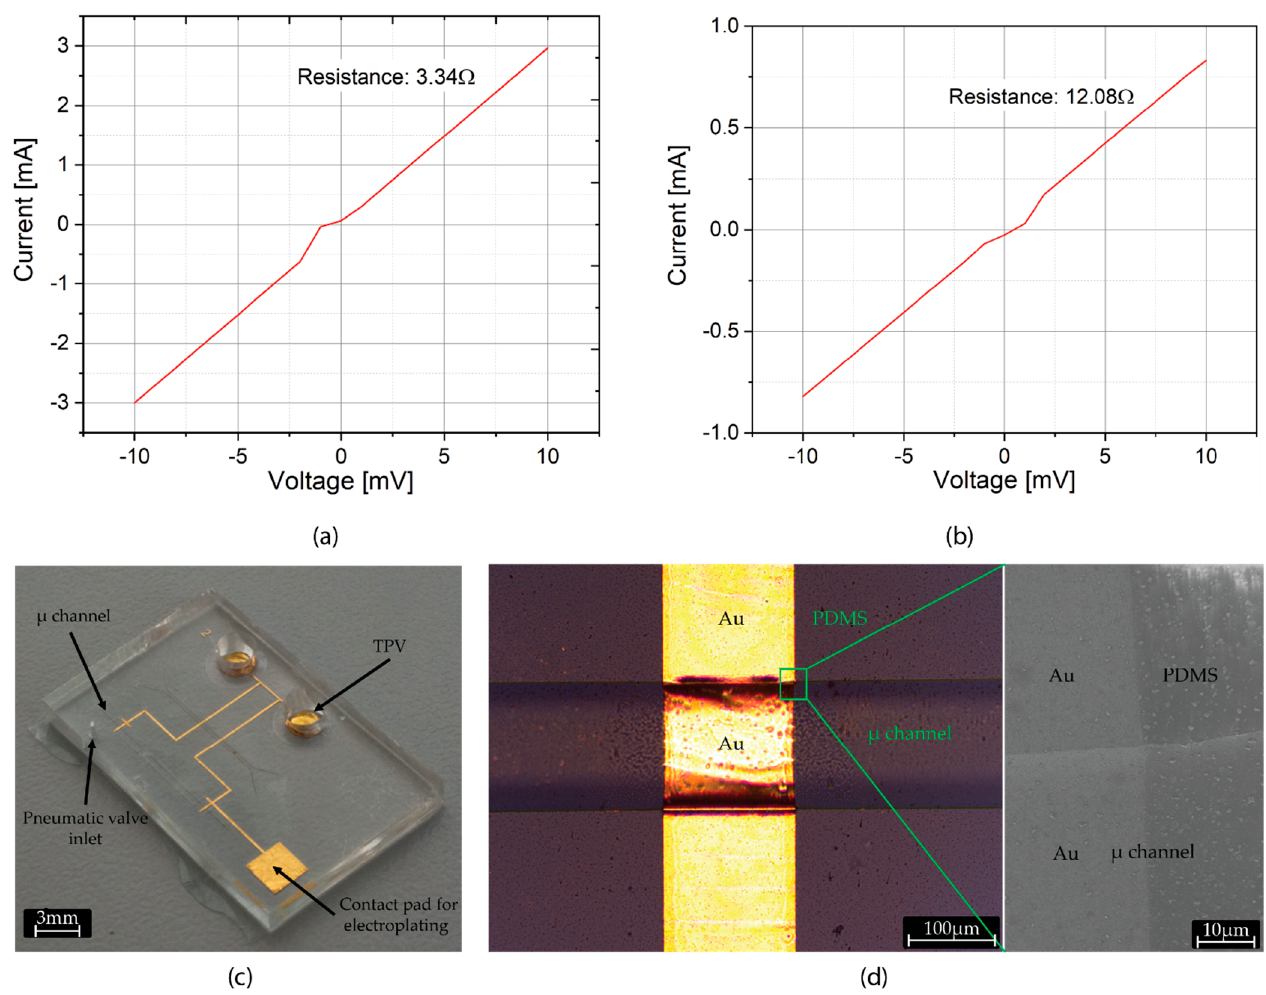
Figure 5. ( a ) Typical two-point resistance measurement between one pair of SU-8 pillars (5 mm apart) before anodic release from wafer. ( b ) Typical two-point resistance measurement between one pair of SU-8 pillars (5 mm apart) after anodic release from wafer. Increase in resistance upon release is due to loss of sacrificial aluminum layer, which provided additional conductive path apart from gold. ( c ) Microfluidic module after sacrificial release, featuring the pseudo-RE network and TPVs. ( d ) Optical (left) and corresponding SEM (right) image of the microchannel showing conformally coated gold pseudo-RE lines in the microchannel. The surface of the pseudo reference electrode exposed to the electrolyte is approximately 150 µm × 100 µm in size, where the exposed length of the electrode is slightly larger than 150 µm due to conformal path in the microchannel.